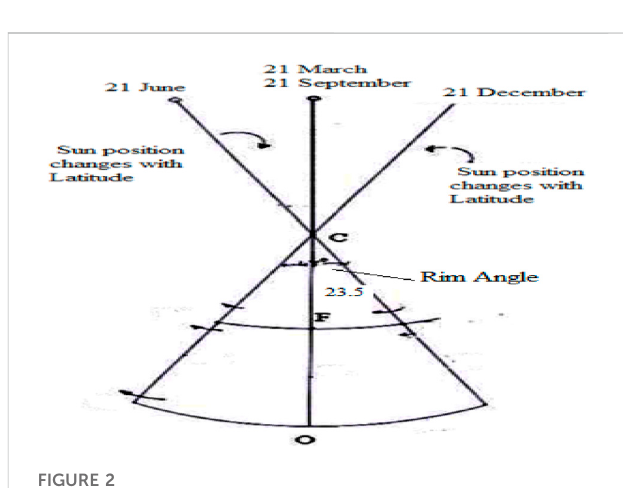
FIGURE 2 Path of the receiver showing a rim